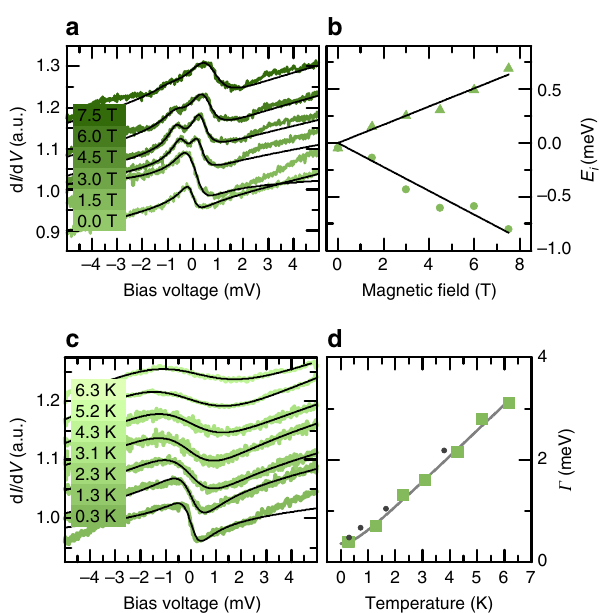
Fig. 3 Kondo screening of the hcp hollow cluster. a Colored lines are spectra taken at the indicated magnetic fi elds on the hcp hollow cluster ( T = 0.3 K). The black lines are fi ts to the sum of two Fano-functions (values of the full width at half maximum Γ ≈ 0.5 meV and of the form factor q , see Supplementary Note 3, Supplementary Table 3, and Supplementary Fig. 6). b Symbols are the magnetic fi eld dependent energetic positions of the Kondo resonances extracted from the fi tted Fano-functions in a . The solid lines are linear fi ts through ( E i , B ) = (0,0) resulting in the g -factors of 1.46 and 1.91 for the positive and negative energy side, respectively. c Measured temperature dependence of the Kondo resonance ( colored lines , B = 0T), together with fi tted single Fano-functions ( black lines , E i ≈ 0 meV, values of q , see Supplementary Table 4). d Temperature dependency of the width Γ of the Kondo resonance extracted from the fi tted Fano-functions in c , together with a fi t to a power law ( gray line ) and to numerical renormalization group calculations for a spin-1/2 impurity in the strong coupling regime ( gray dots , taken from ref. 40